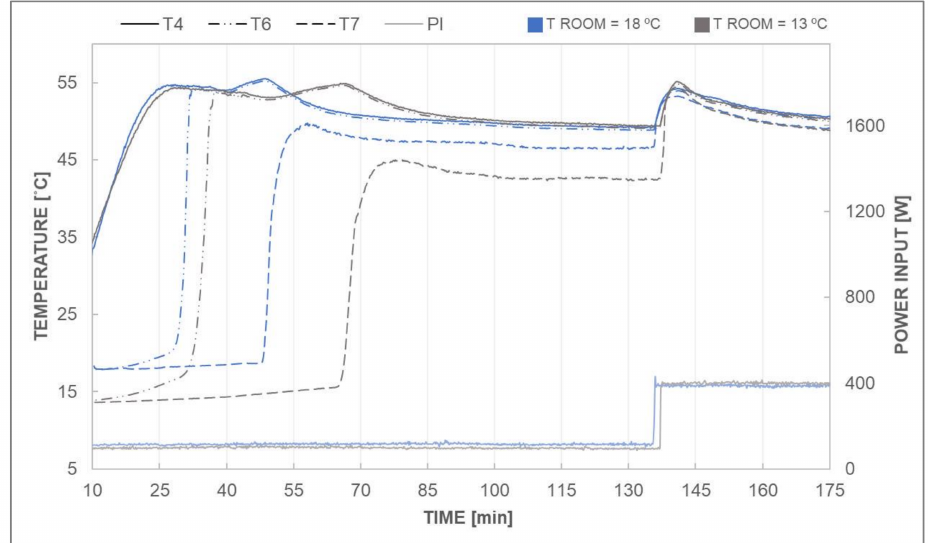
Figure 5. Room temperature effect on thermosyphon